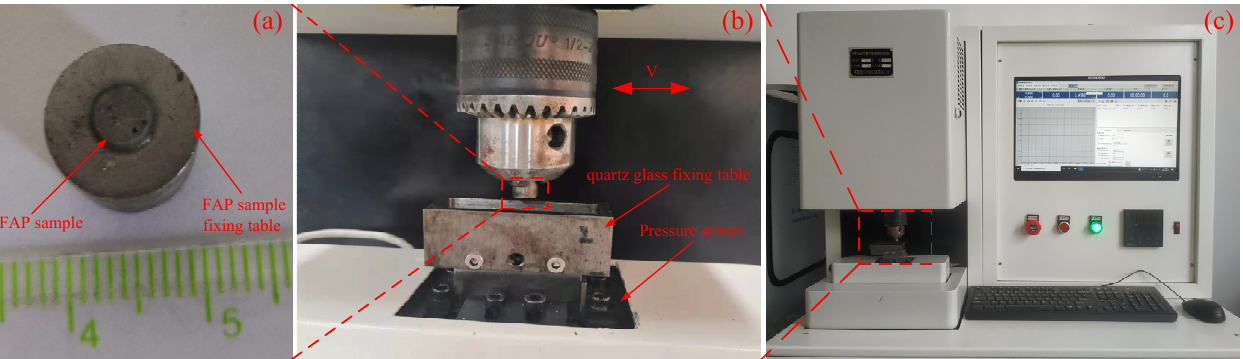
Figure 4. Flow chart for experiment.